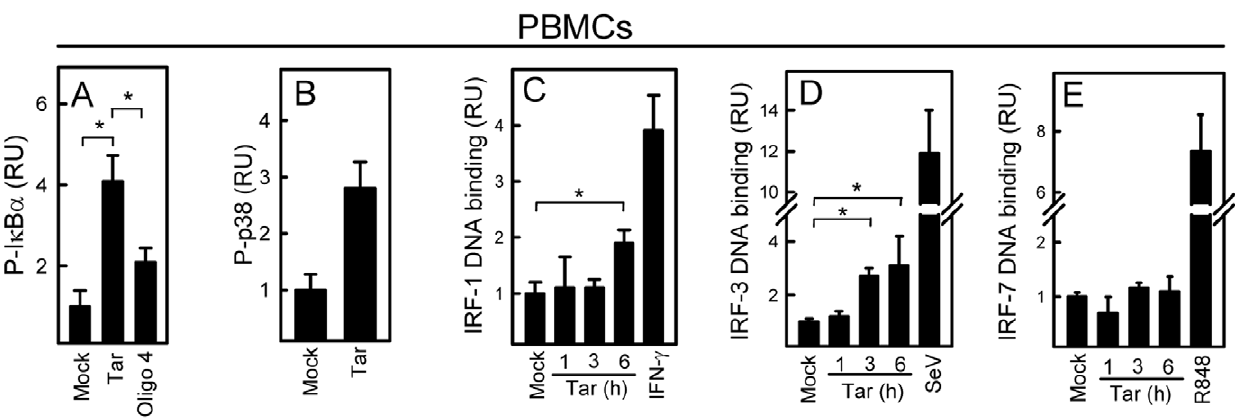
Figure 3. HIV RNA activates the NF- k B, p38, and IRF signaling pathways. PBMCs were stimulated with HIV Tar (oligo 2, 2 m g/ml) and in panel A also with oligo 4 (2 m g/ml). (A–B) Whole-cell lysates were isolated 2 h post treatment, and (C–E) nuclear extracts were isolated at the indicated time points (IFN- c , 10 ng/ml, 6 h; SeV, MOI 1, 6 h; R848, 500 ng/ml, 6 h). (A–B) P-I k B a and P-p38 were measured by Luminex technology and (C–E) DNA binding of IRF-1, 3, and 7 to an ISRE consensus sequence was measured by TransAM. Data are shown as means of duplicates or triplicates + / 2 st.dev. Similar results were obtained in two or three independent experiments. RU, relative units. Mock, Lipofectamine 2000 alone. *, p , 0.05.